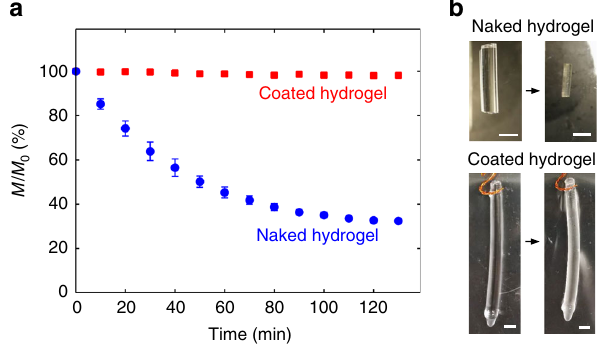
Fig. 10 Weight loss of hydrogels deep-fried at 120 °C. a Normalized weight as a function of time for naked hydrogels and coated hydrogels deep-fried at 120 °C. The coated hydrogels maintain the weight while the naked hydrogels keep losing water over the frying time. After 130 min, the coated hydrogel preserves ~98% of its original weight, while naked hydrogel decreases to ~33% of its original weight; 33% weight corresponds to the dry polymer content in the hydrogel ( n = 5). b Images of the hydrogels before and after frying. The scale bar is 1